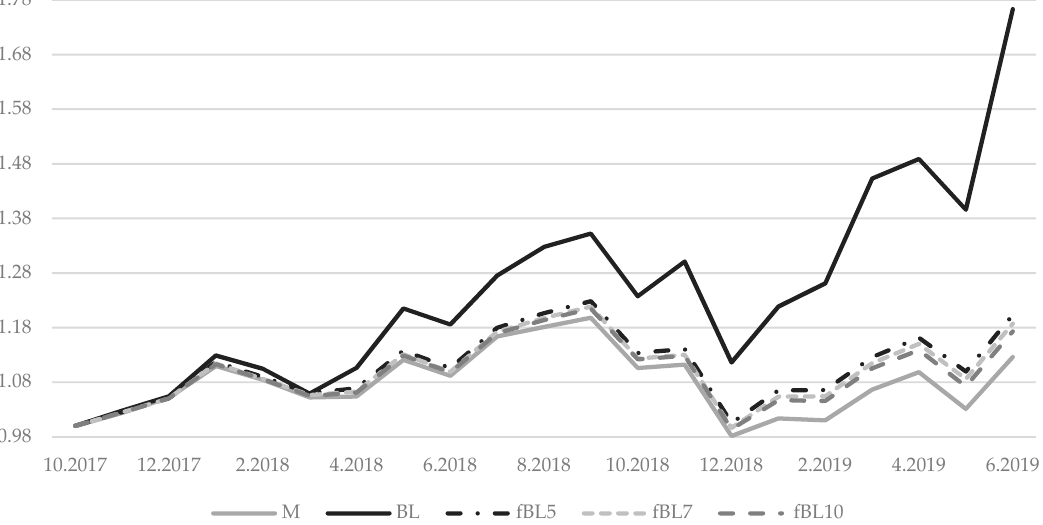
Figure 4. Average investment performance with short sale.